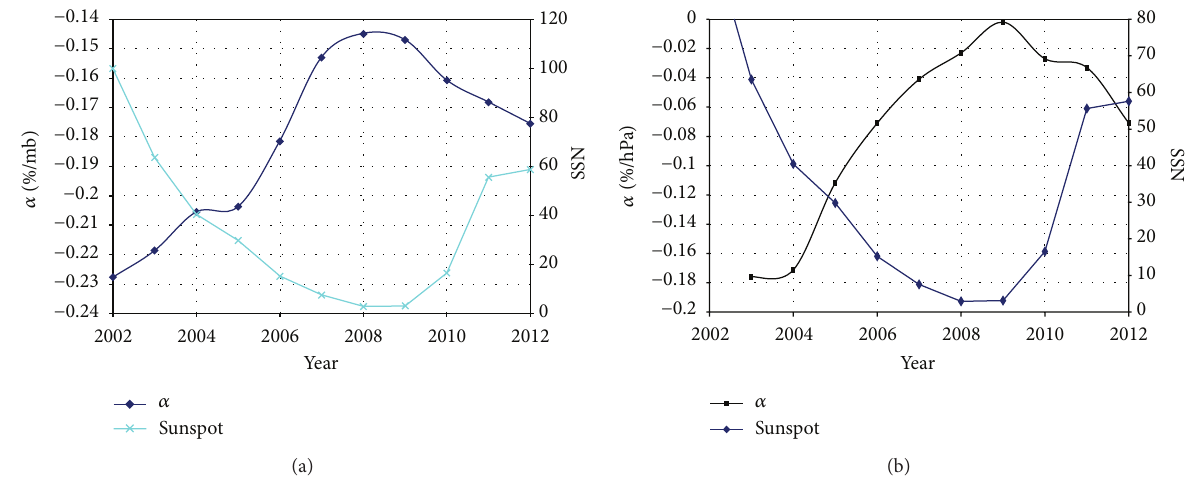
Figure 7: (a) The annual values of the barometric coefficient 𝛼 for Riyadh and the sunspot number (SSN) for the period 2002 to 2012. (b) is the same as (a) but for Adelaide muon detector for the period 2003 to